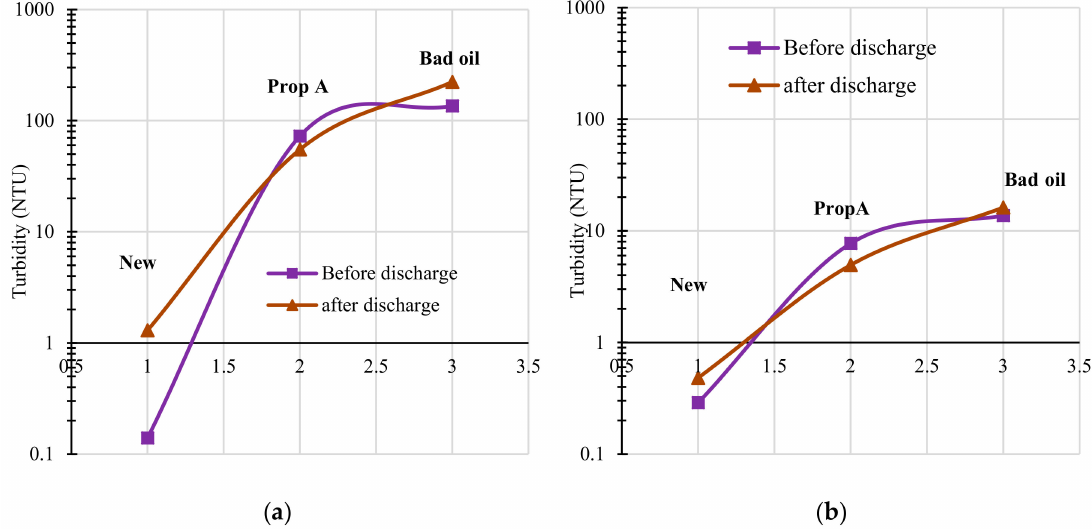
Figure 4. Change in turbidity of liquids at di ff erent aging conditions for before and after discharge: ( a ) for mineral oil; ( b ) for synthetic